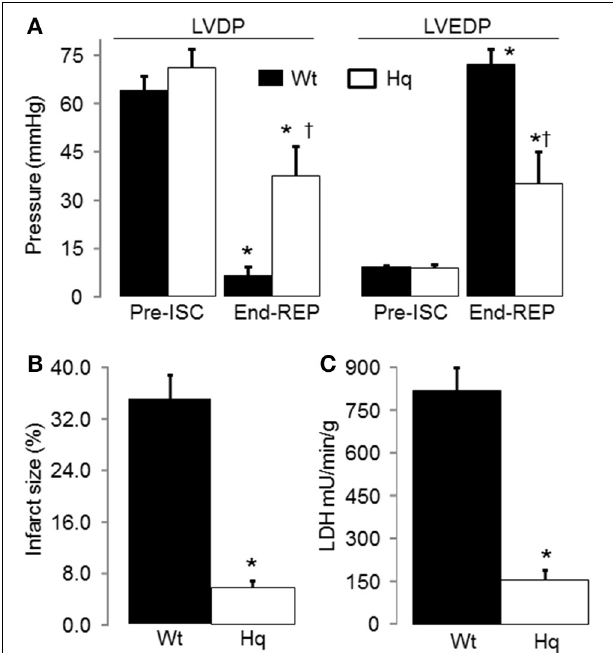
FIGURE 2 | IR led to decreased cardiac injury in Harlequin mice compared to wild type. Heart rate was maintained at 420bpm by pacing during 15min equilibration perfusion. The pacing was stopped during ischemia and resumed at 15min reperfusion. The recovery of myocardial contractile function during reperfusion, shown by the improvement in left ventricular developed pressure (LVDP mmHg, A ), was improved in Harlequin mice compared to wild type. The diastolic function was also improved in Harlequin mice following IR, reflected by a decrease in left ventricular end-diastolic pressure (LVEDP) at the end of reperfusion (B) . The cardiac injury during IR was decreased in Harlequin mice as shown by a smaller infarct size (C) and less LDH release into coronary effluent. Data are expressed as mean ± s.e.m.; ∗ p < 0 . 05 vs. time control (TC); † p < 0 . 05 vs. wild type untreated IR.